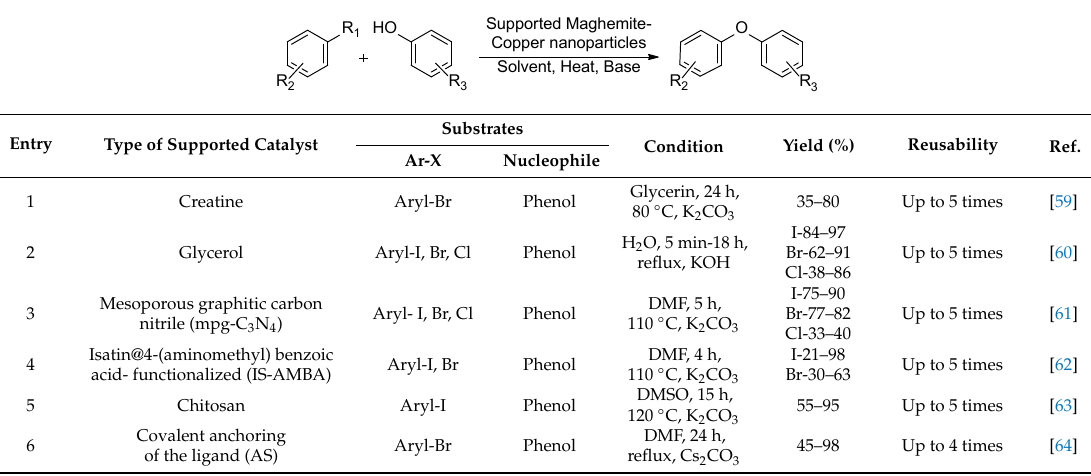
Figure 9. Preparation method of Cu 2